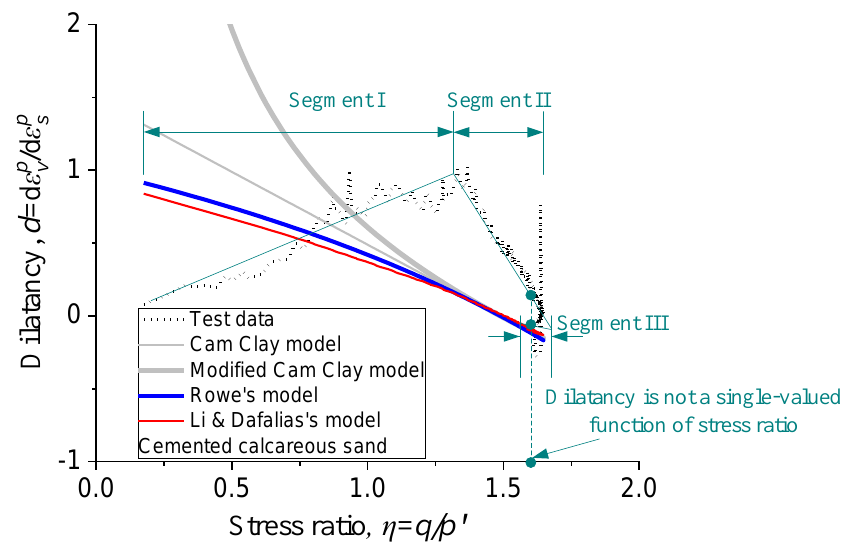
Figure 14. Comparison of predictions of stress − dilatancy relationship ( p (cid:48) The significance of considering the turning hook in the stress-dilatancy curve for crushable calcareous sand is that the more precise the turning hook simulation, the more precise the volumetric strain prediction.